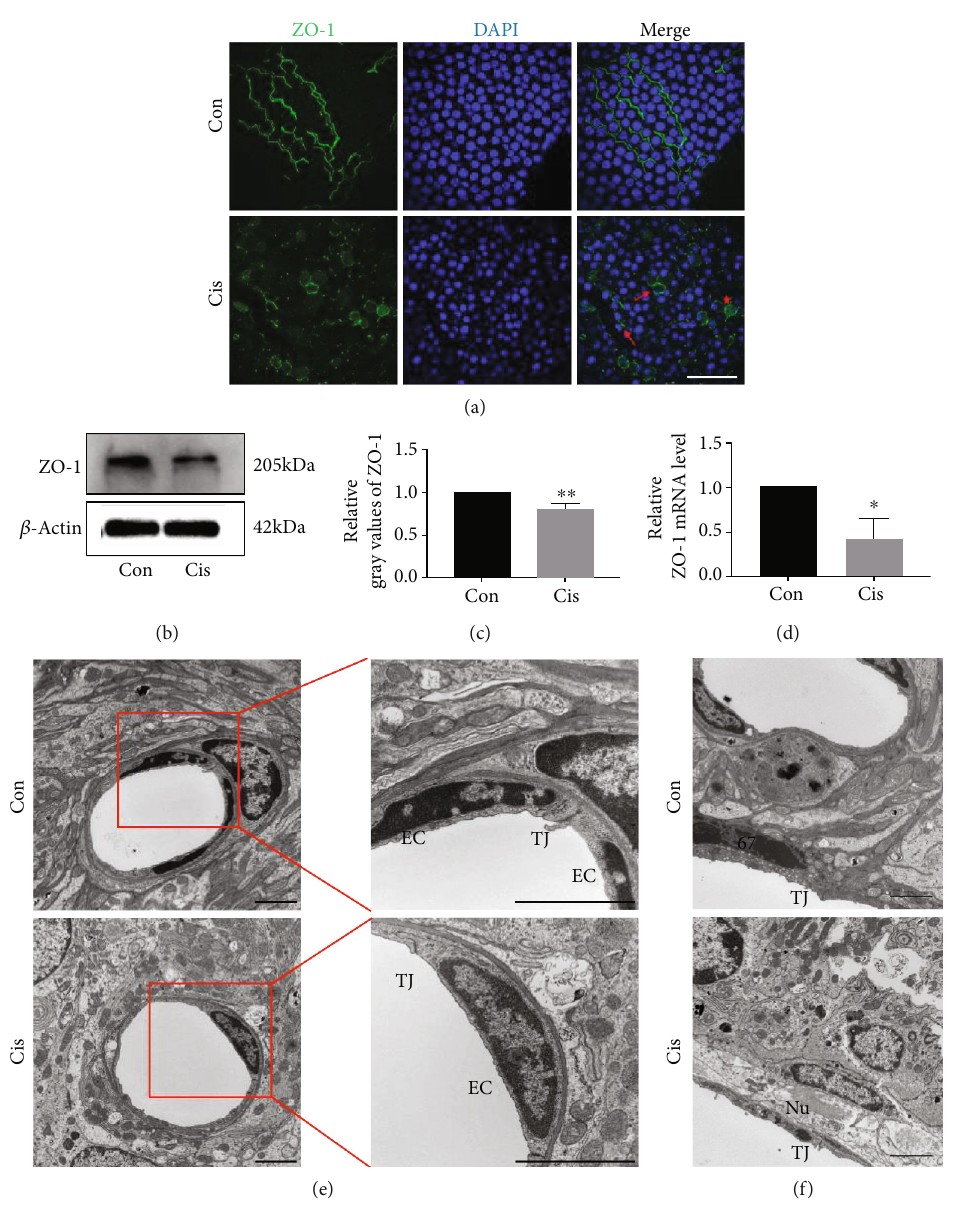
Figure 3: Cisplatin alters the expression pattern and decreases the expression of ZO-1 in SV. (a) The distribution of ZO-1 (green) in MCs by immuno fl uorescence staining. The moderate-to-strong ZO-1 signal is visible as a continuous wavy line between adjacent MCs in control mice, while the weak-to-moderate ZO-1 signal is seen mainly in the cell cytoplasm in cisplatin-treated mice. Asterisks show holes formed between marginal cells. Arrows point to morphological alterations in intercellular junctions. Nuclei were stained with DAPI (blue). Scale bars, 100 μ m. (b) Western blot analysis of the cell lysates of SV treated with cisplatin. β -Actin was used as a loading control. (c) Densitometric quanti fi cation of the mean (SD) ratio of ZO-1 expressed as mean ± SD ( n = 3 ). (d) qRT-PCR shows mRNA for ZO-1 in the SV ( n = 3 ). (e) The ultrastructure of SV was analyzed by TEM. TJs between adjacent ECs were extremely tight in control mice; the right window (zoomed inset) displays a higher magni fi cation of the TJs between ECs; TJs were open and intermittently widened between adjacent ECs in cisplatin-treated mice. Scale bars, 2 μ m. (f) TJs between adjacent MCs were extremely tight in the control mice; TJs were open between adjacent MCs in cisplatin-treated mice. Scale bars, 2 μ m. Con: 0.9% physiological saline; Cis: cisplatin; TJ: tight junction; EC: endothelial cell; m: mitochondrion; Nu: marginal cell nucleus. ∗ p < 0 : 05 , ∗∗ p < 0 : 01 , and ∗∗∗ p < 0 : 001